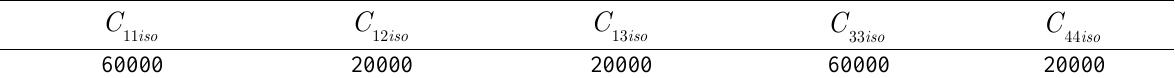
Table A2. Elasticity coefficients of isotropic materials used for